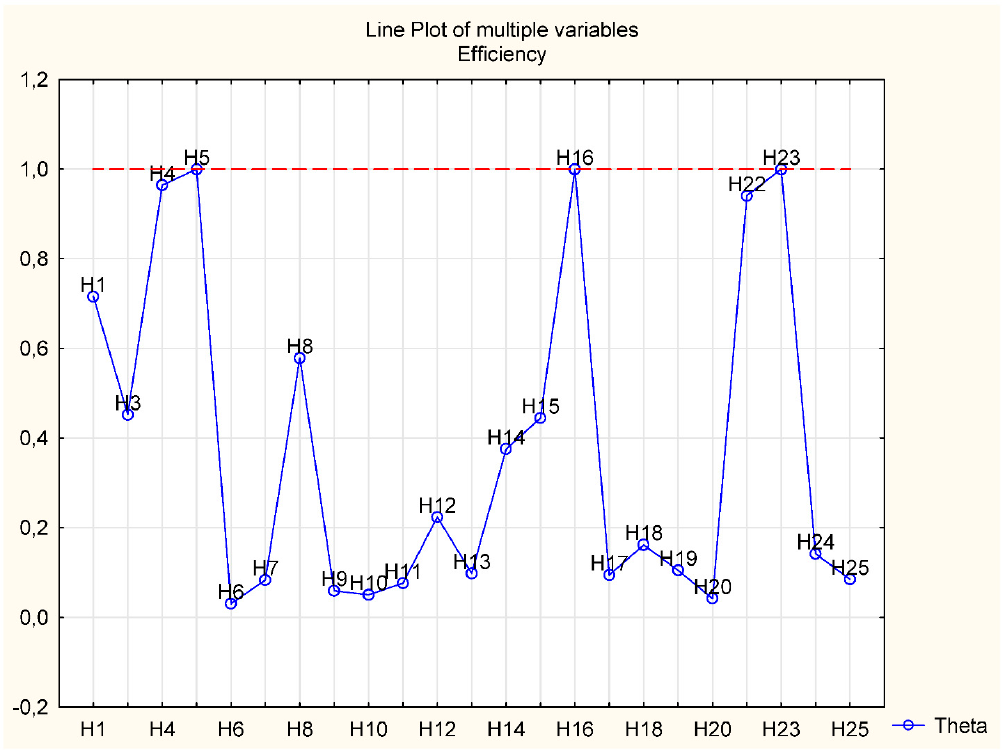
Figure 3. Results of efficiency.